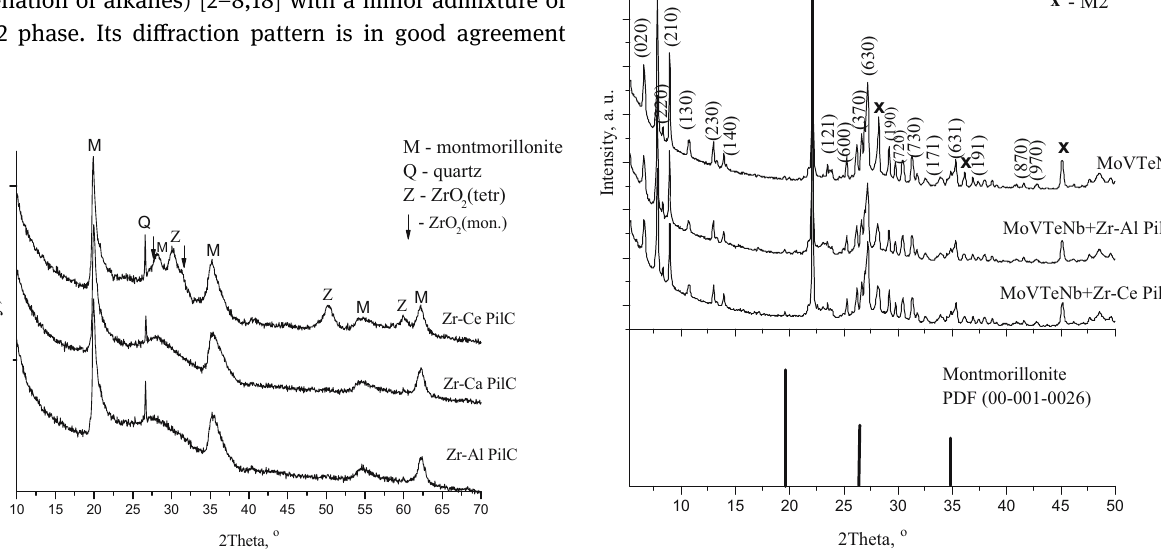
Figure 2: Di ff raction patterns of bulk VMoTeNbO and its composites with 10 wt% of Zr – Ce - or Zr – Al - pillared